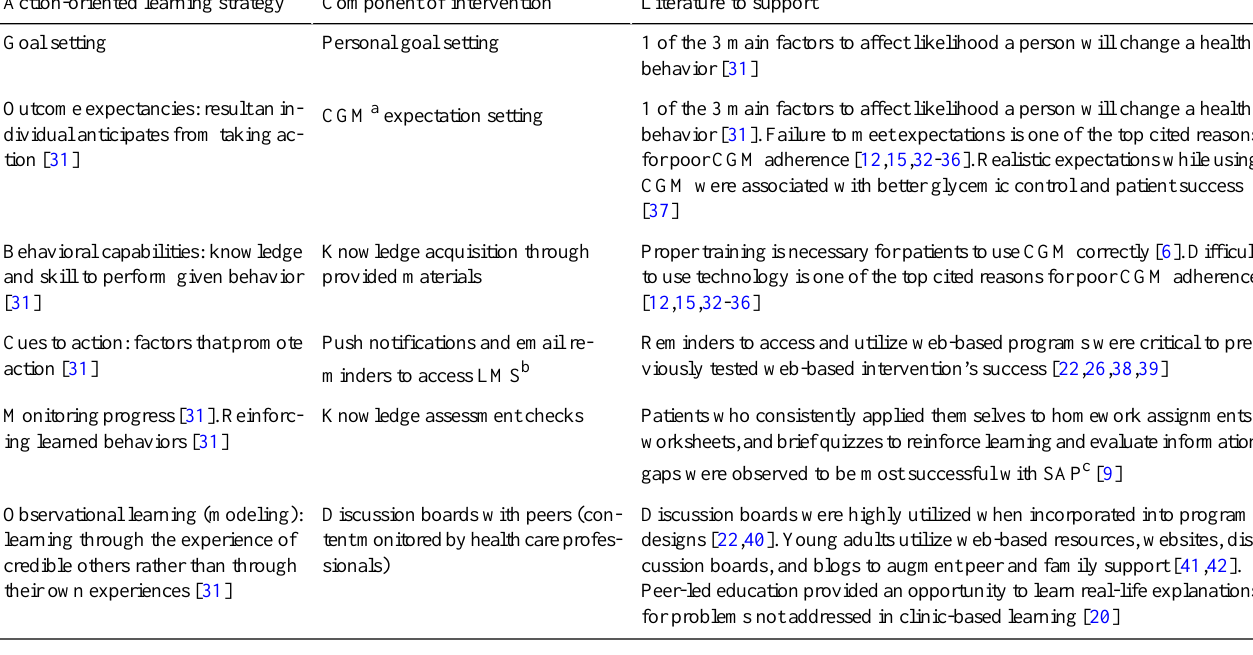
Table 2. Evidence to support action-oriented learning strategies incorporated into the web-based intervention